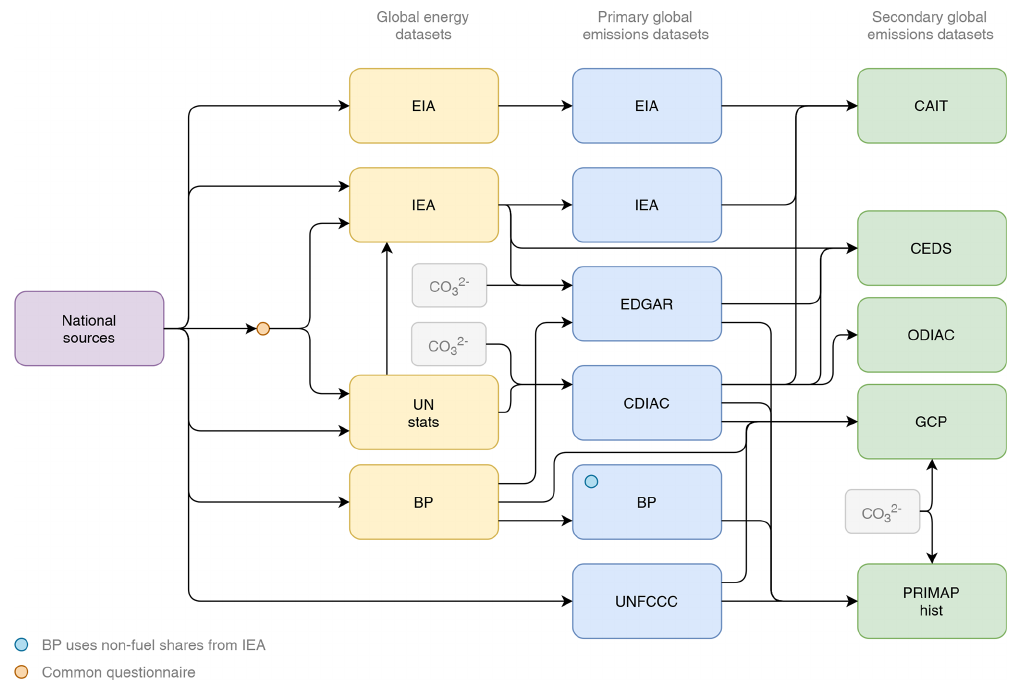
Figure 1. Dependencies of selected global energy and CO 2 emissions datasets. Here a “primary” emissions dataset is one that calculated emissions directly from energy data, rather than collating emissions estimates from other sources. In addition to energy data sources, some emissions datasets include emissions from carbonates, which rely on other data sources. Some national data are first collated by regional organisations. “UN stats” is the United Nations Statistics Office (not